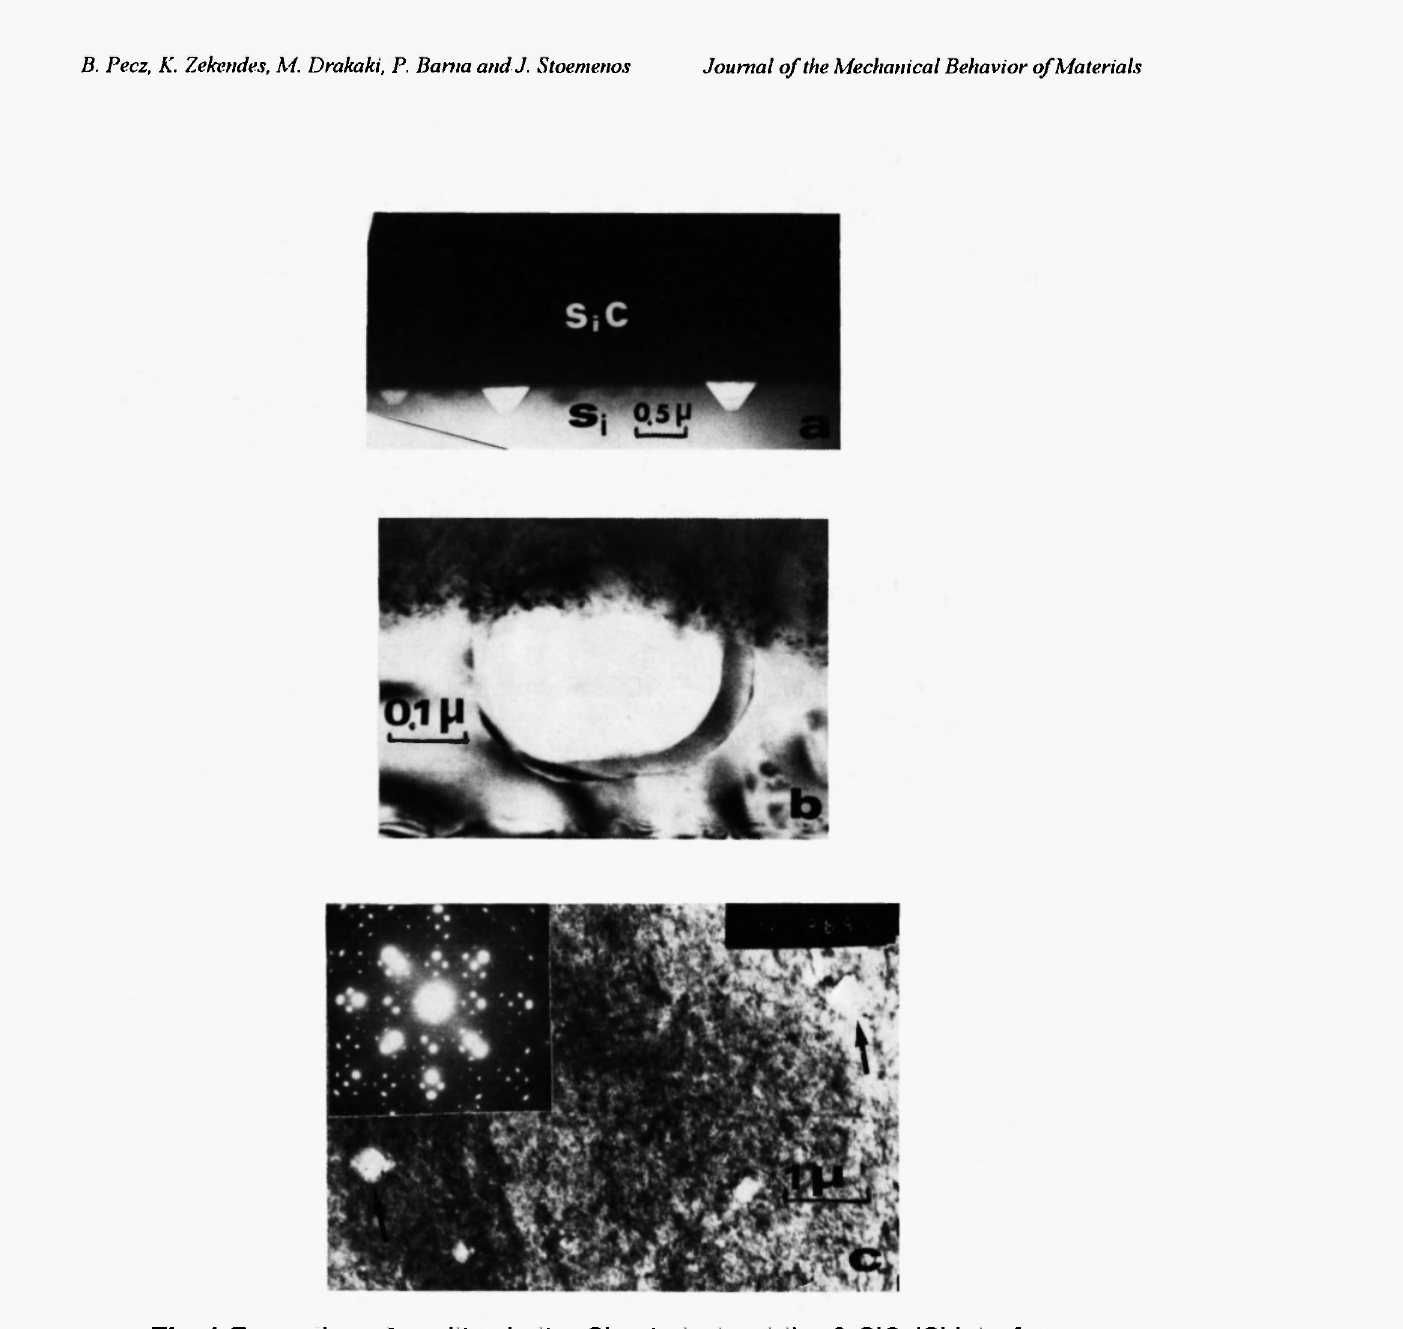
Fig.4 Formation of cavities in the Si-substrate at the ß-SiC /Si interface. a) Cross-section micrograph from the interface. Cavities having reverse pyramid like shape are evident. b) Plane view micrograph from the interface. A cavity with rounded corners partially covered by the ß-SiC overgrown is shown. c) Low magnification plane view micrograph from the interface reveals the distribution of the Si-cavities. The cavities appear as small rectangularl pits. The diffraction pattern in the inset reveals the presence of the Si-substrate and the ß-SiC